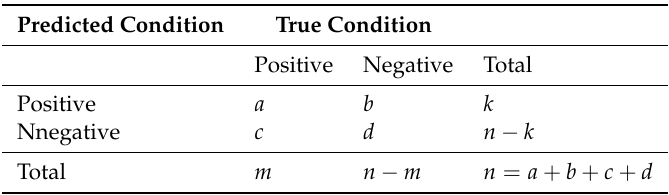
Table 1. Confusion table: a is the number of true positives, b the number of false positives, c the number of false negatives and d the number of true